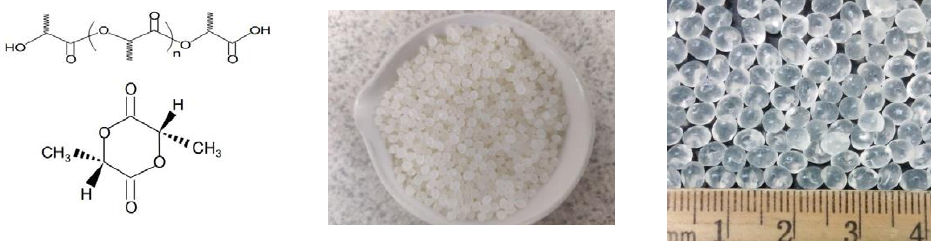
Fig. 1. PLA resin beads (Natureworks, LLC) and molecular structures (repeat and dimer) Figure 1. PLA molecular structure, ~3 mm resin beads in cup and closeup with scale – PLA resin supplied by Natureworks, LLC.